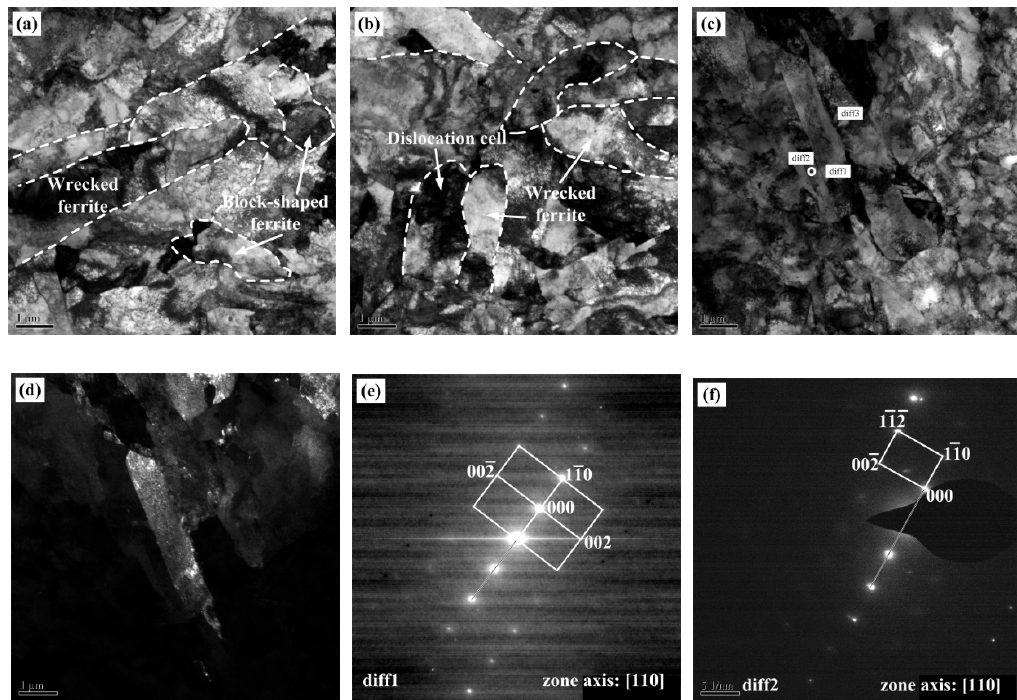
Figure 5. Micrographs from TEM observation for 22 mm X80 pipeline strip: ( a – c ) substructure, ( d ) dark-field image of parallel microstructure, and ( e , f ) corresponding diffraction spots.